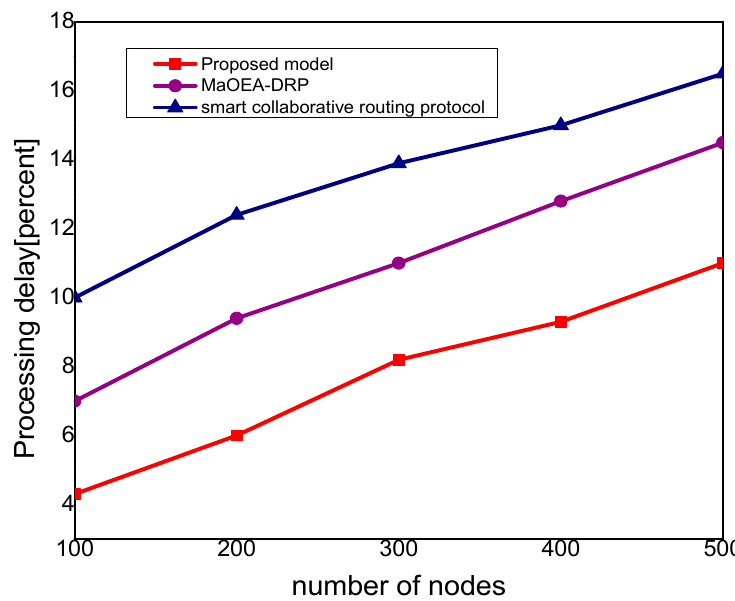
Figure 5. Processing delay with the number of nodes.